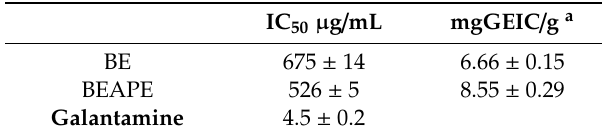
Table 3. AChE inhibitory properties of the ethanolic extract from bulb (BE) and aerial parts (APE) of A. subhirsutum